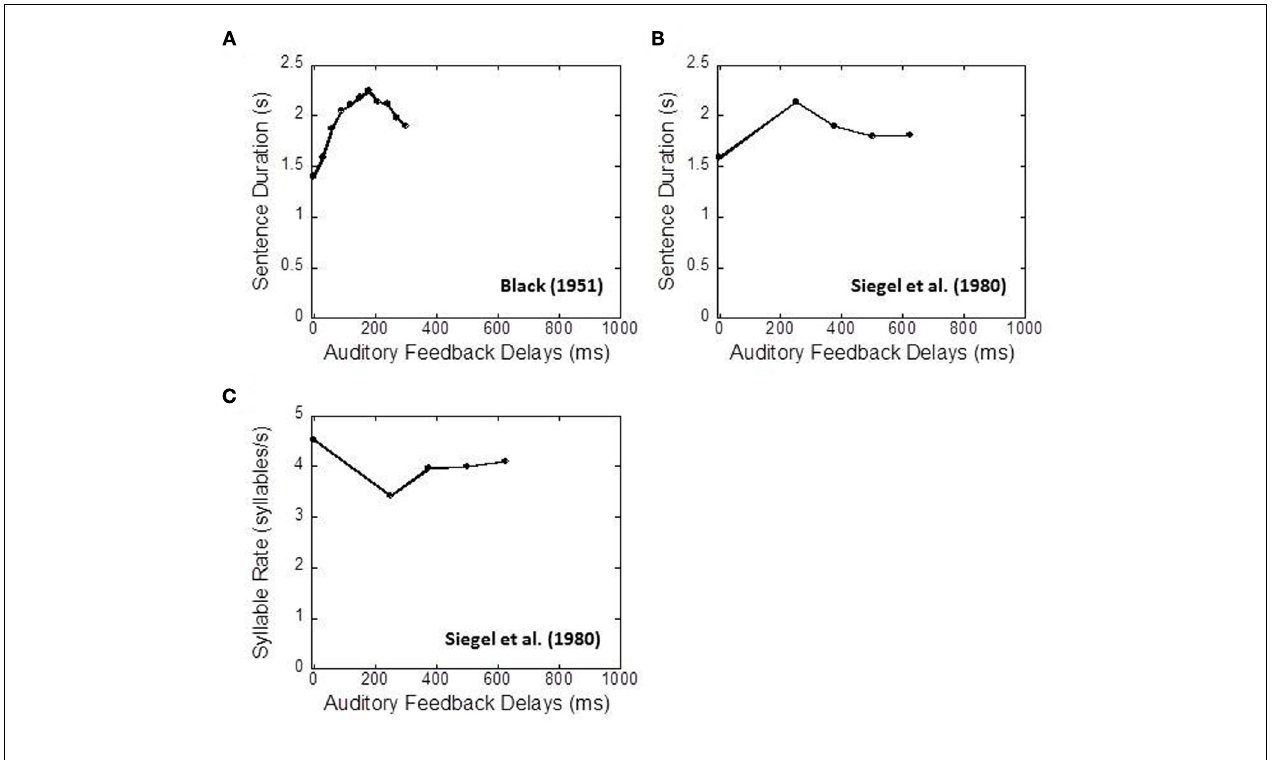
FIGURE 1 | Examples of speech disruption under delayed auditory feedback. (A) Duration of reading five-syllable phrases. Replotted from Black (1951),Table 2. (B) Duration of reading